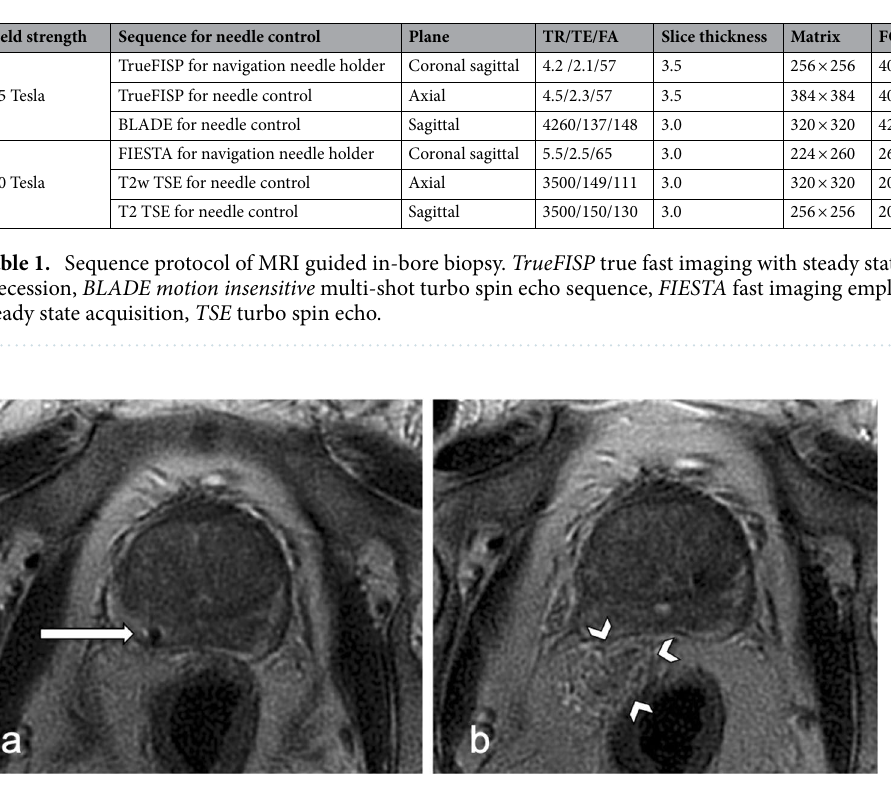
Figure 2. Small rectoprostatic hematoma of 3 ml (arrowheads); axial T2 weighted fast imaging in a 77 years old patient with continued antiplatelet therapy; ( a ) first intraprostatic needle documentation, inside the peripheral zone on the right (arrow); ( b ) needle documentation at the end of the